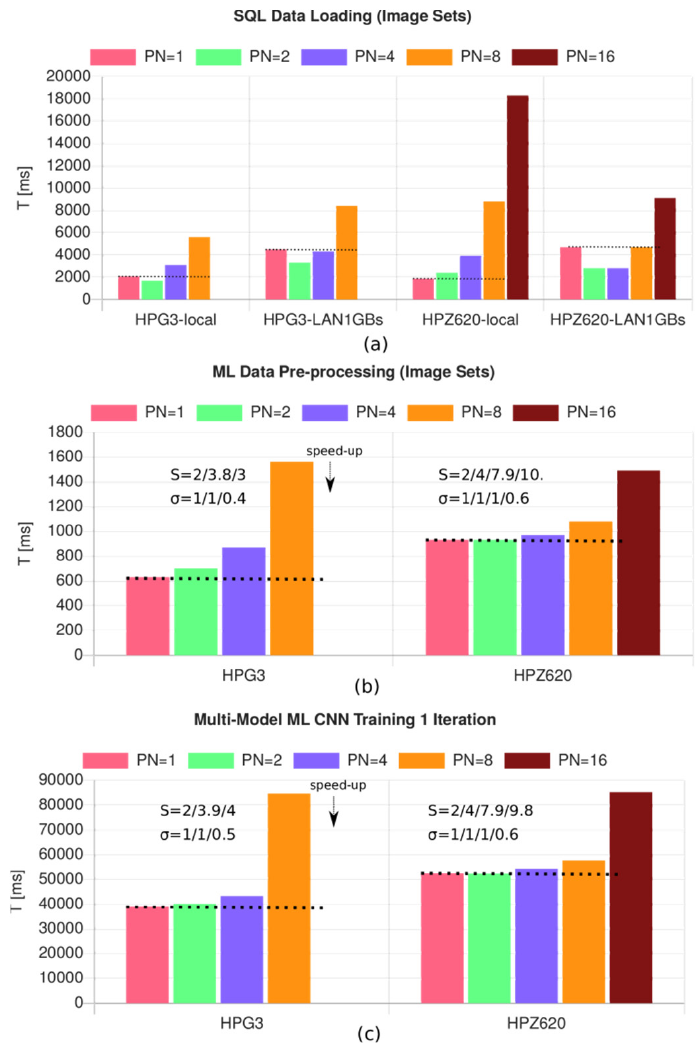
Figure 14. Results of the total computation times, with shell worker processing of multi-model CNN-ML tasks with a different number of workers (PN). S: speeding up, σ : scaling up, HPG3: NC = 4, HPZ620: NC = 12. ( a ) Input data loading times from the SQL data base; ( b ) data pre-processing times; ( c ) training times.